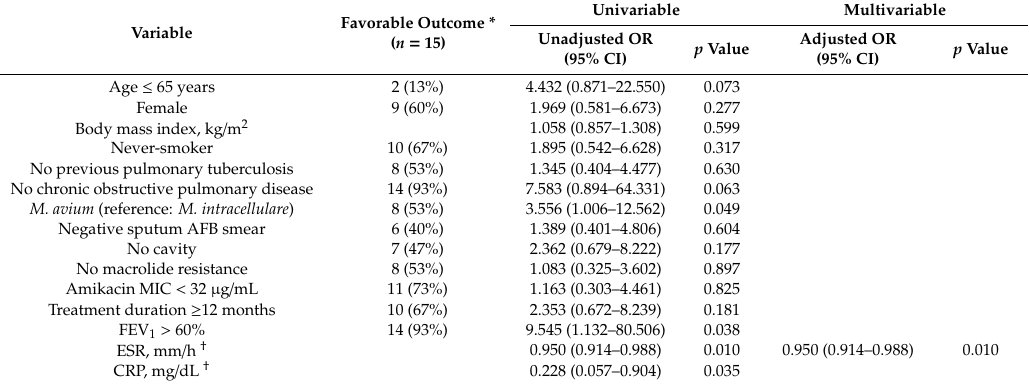
Table 5. Univariate and multivariable analyses of factors associated with favorable outcome ( N = 52).